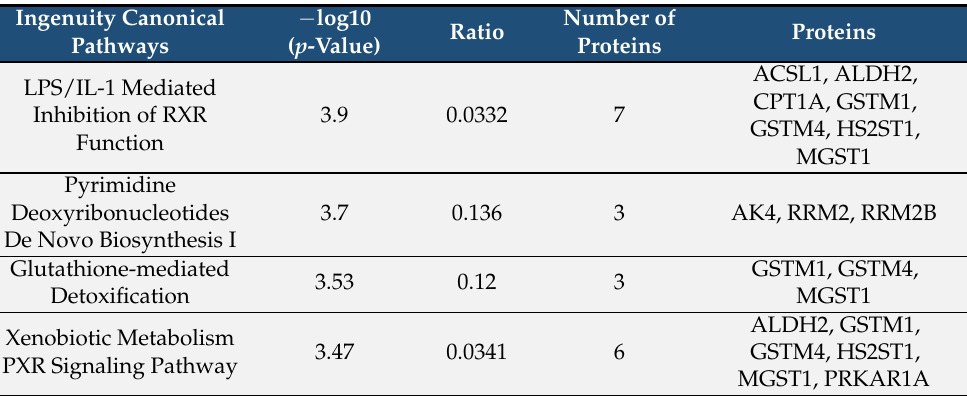
Table 5. Top 5 canonical pathways generated with the 111 differentially abundant proteins in RBPMS SG2 vs. EV clones.